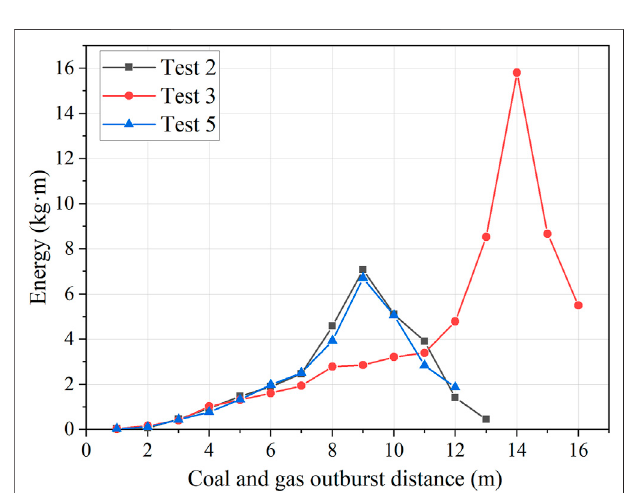
FIGURE 9 | Variation characteristics of outburst energy with distance of throwing